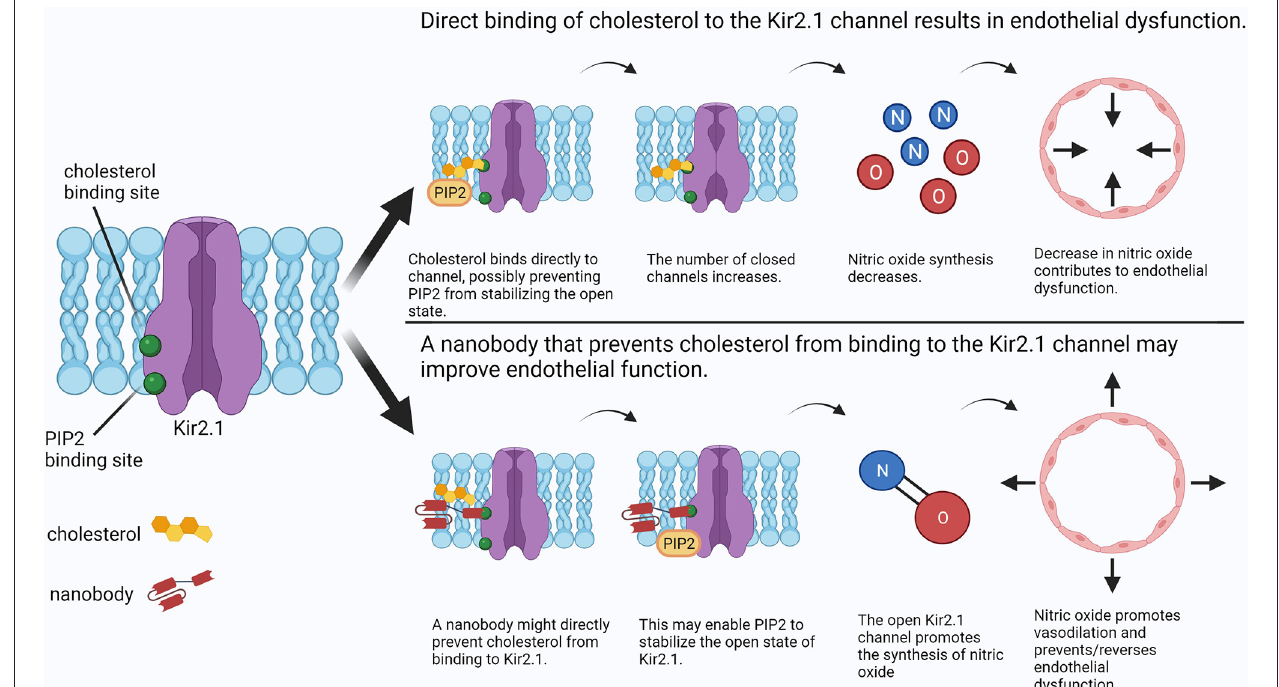
FIGURE 1 | Comparison between cholesterol-induced Kir2 channel inhibition and a putative nanobody therapeutic preventing cholesterol-Kir2 interaction. In the presence of elevated cholesterol, cholesterol may bind directly to Kir2, preventing PIP2 from stabilizing the open state and resulting in channel inhibition. Consequently, nitric oxide synthesis is decreased resulting in endothelial dysfunction. A possible treatment may use an antibody to directly prevent cholesterol from binding to Kir2 while still allowing channel regulation by PIP2. Physiological synthesis of nitric oxide is restored, preventing or reversing endothelial dysfunction. Created with